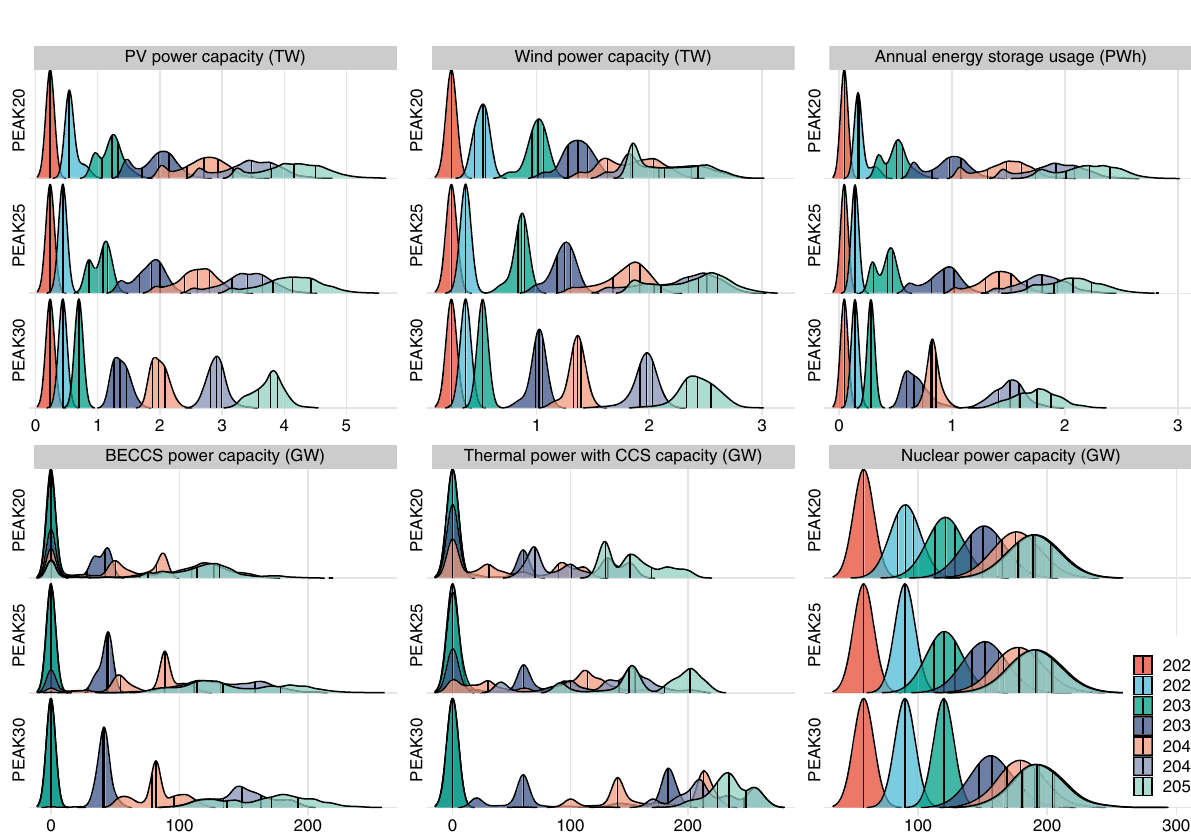
Fig. 5 Probability density distribution of promising technologies in different periods. Figure shows the kernel density estimation results for the PV power installed capacity (unit: TW), wind power installed capacity (unit: TW), annual energy storage technology usage (unit: PWh), BECCS power installed capacity (unit: GW), thermal power with CCS installed capacity (unit: GW) and nuclear power installed capacity (unit: GW). The black line in the graph represents the fi rst quantile, intermediate range (IQR), and third quantile for all the cases. PV photovoltaic, BECCS bioenergy with carbon capture and storage, CCS carbon capture and